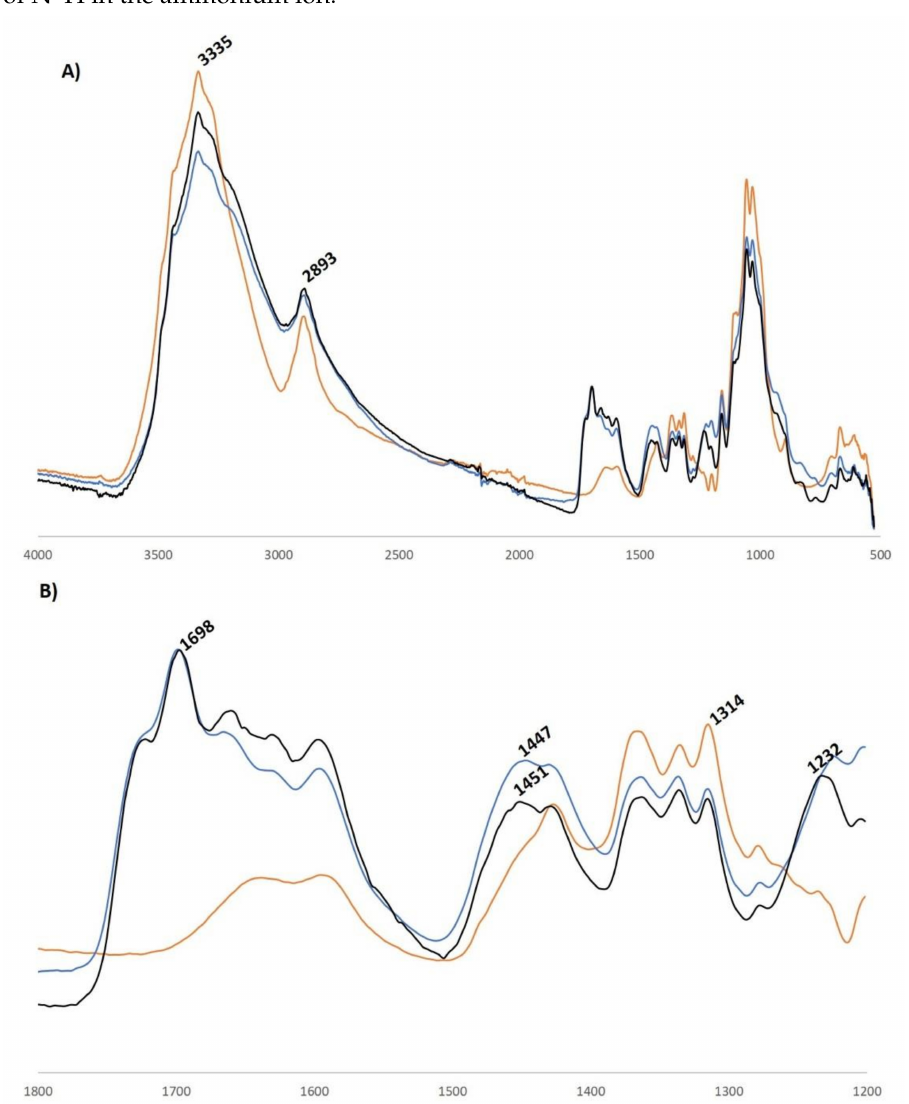
Figure 3. FT-IR spectra of cotton (orange), Co-P-isosorbide (black) and Co-P-sorbitol (blue) from 500–4000 cm − 1 ( A ) and a detailed view from 1200–1800 cm − 1 ( B ). The presence of phosphorus in the different materials was assessed via XRF